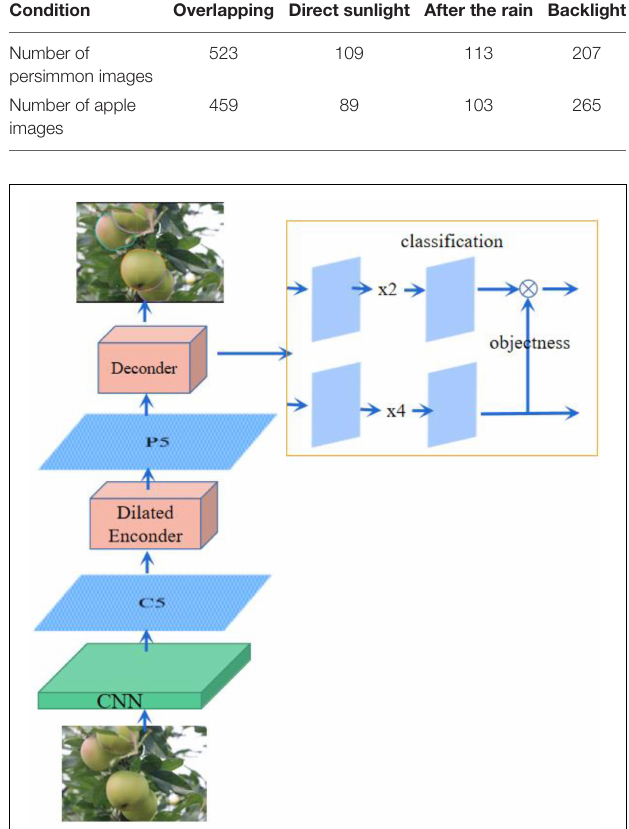
FIGURE 2 | YOLOF structure schematic